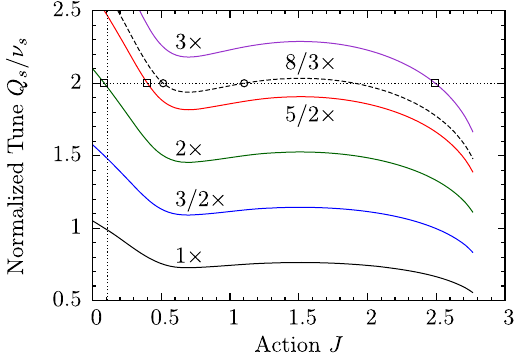
= ν FIG. 15. Normalized synchrotron tune Q as functions of s s ¼ 2 horizontal dotted-line interception = ν the action J . The ν m s illustrates the parametric resonances driven by phase modulation where the double rf parameters are r ¼ 1 = 2 , h ¼ 2 , and Δ ϕ ¼ 45 °. The vertical dotted line where J ¼ 0 . 106 depicts o the initial location of the bunch at the origin of the primary-rf- only phase space. The circular interception points depict the two relevant 8 ∶ 3 resonances that are required to be disrupted to enable a larger chaotic